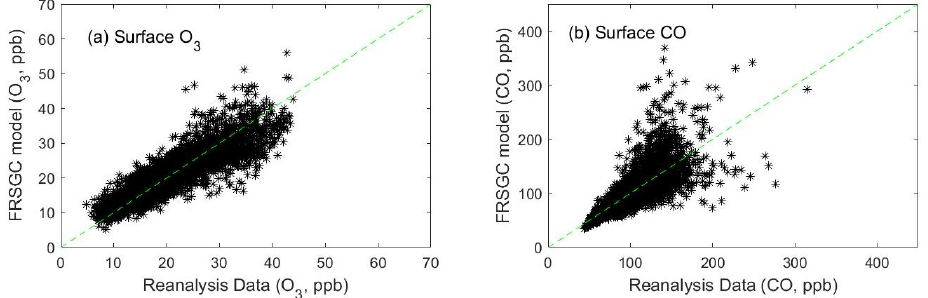
Figure 2. Monthly-mean surface O 3 (a) and surface CO (b) over Europe and North America simulated with the FRSGC/UCI CTM compared with ECMWF reanalysis